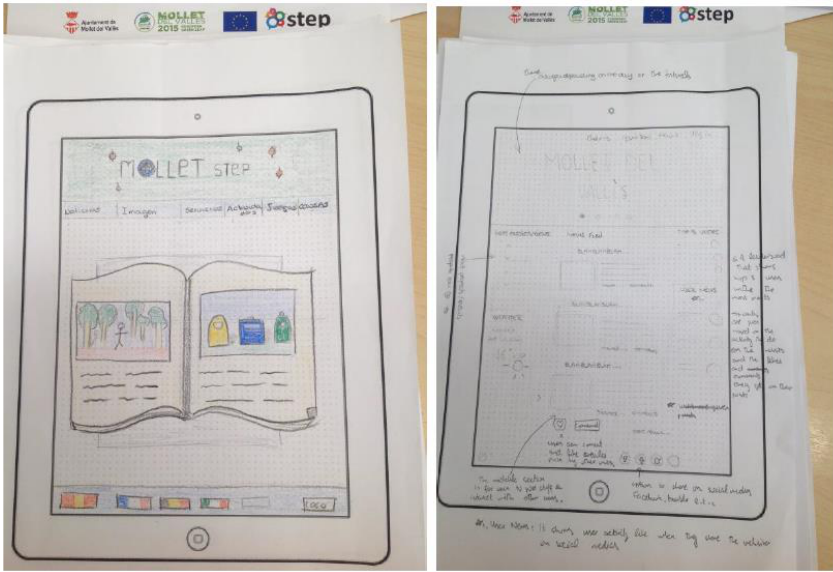
Fig. 5. Detailed sketches for a landing page proposed by YEAs